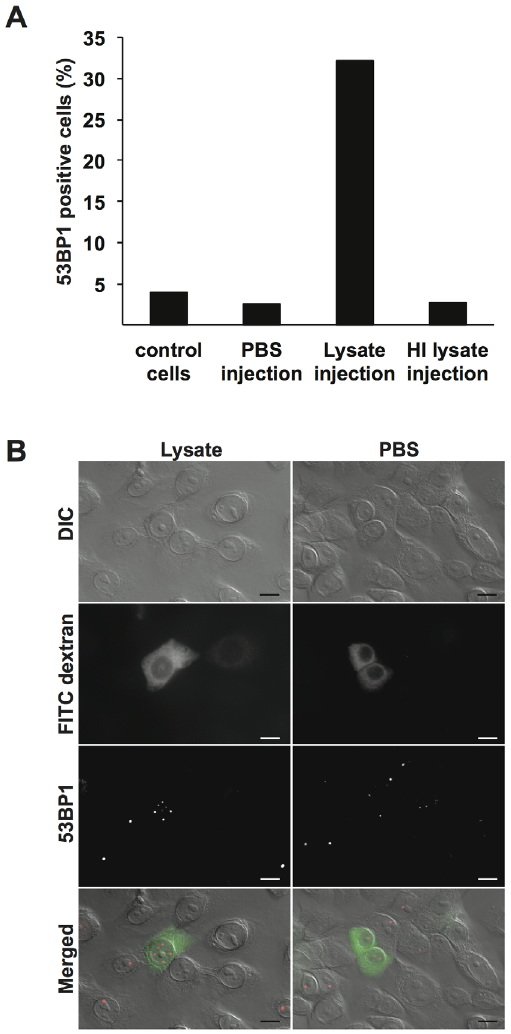
Figure 3. Microinjection of bacterial lysates in the cytoplasm of VK2/E6E7 cells causes DSBs. A. Interphase VK2/E6E7 cells were subjected to cytoplasmic microinjection of bacterial MS11 P + lysate, MS11 P + HI lysate, or PBS. Cells were incubated for 20–24 h and then stained for DSBs with 53BP1 antibodies. The graph shows the average number of 53BP1 positive cells counted in two independent experiments under each condition. Control cells are non-injected cells. B. Images showing DIC and fluorescent images of representative cells microinjected with MS11 P + lysate (left) or PBS (right). FITC-dextran (green) was co- injected into the cytoplasm to identify microinjected cells. Scale bar represents 10 m